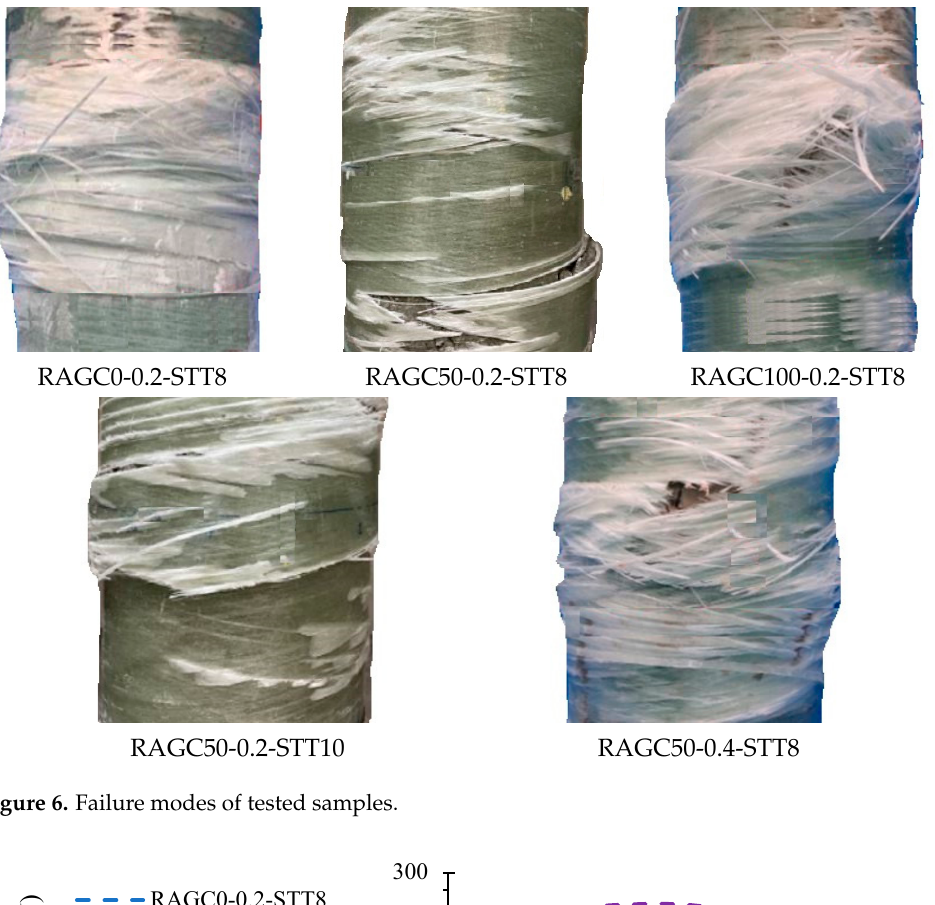
Figure 6. Failure modes of tested samples.